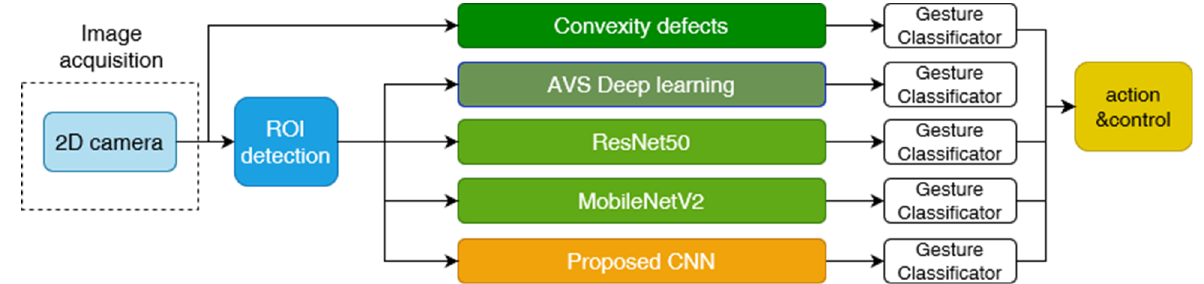
Figure 5. Flow diagram of 2D image processing.